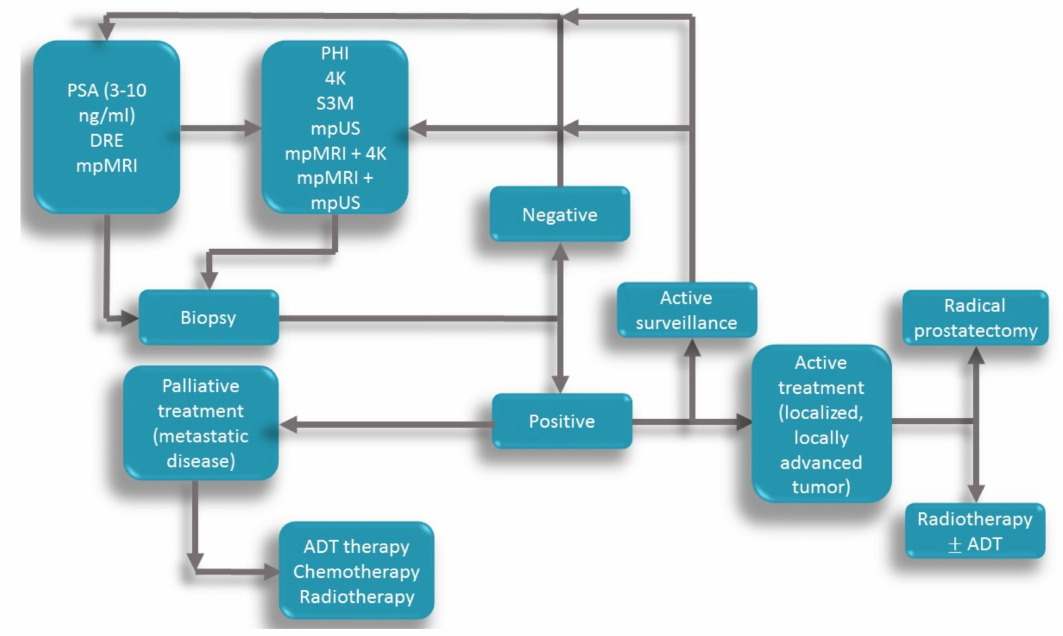
Figure 1. The pathway for diagnosis and treatment of prostate cancer. The diagram represents the patient’s flow from the moment he presents a suspicious PSA level. First, direct rectal examination